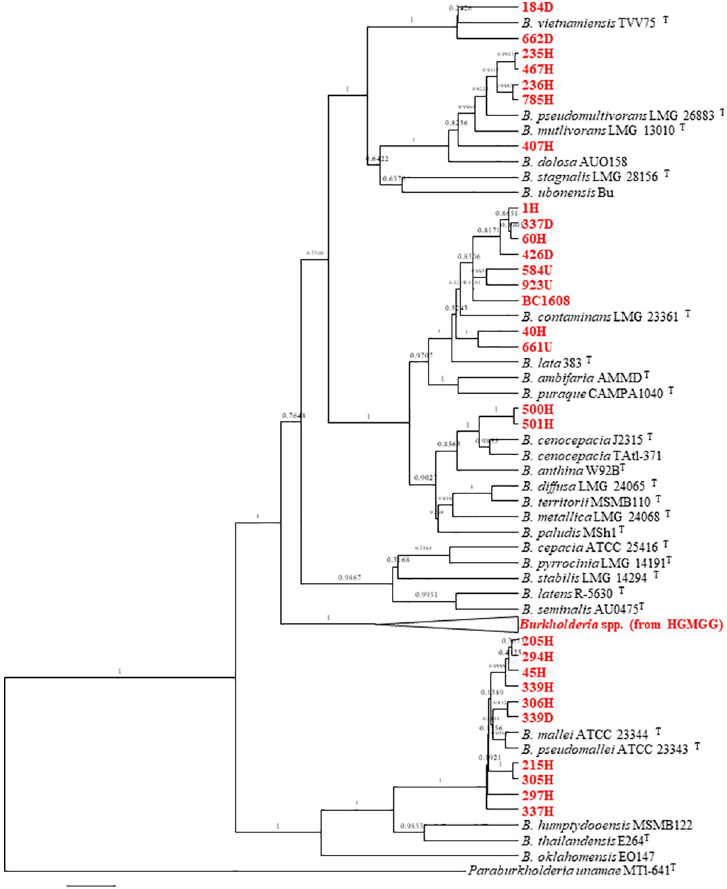
Fig 1. Phylogenetic analysis of Burkholderia species with 16S rRNA and atpD genes with the Bayesian method and the model GTR+G+I. Paraburkholderia unamae MTl-641 T was used as an outgroup. Bar, the nucleotide differences between the sequences. Bayesian posterior probabilities values shown in